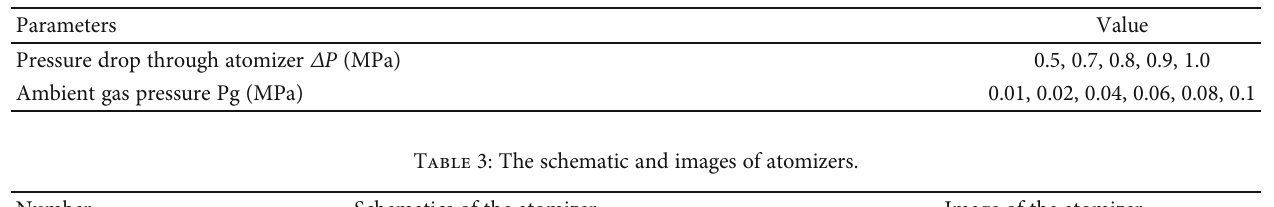
Table 2: Test conditions.